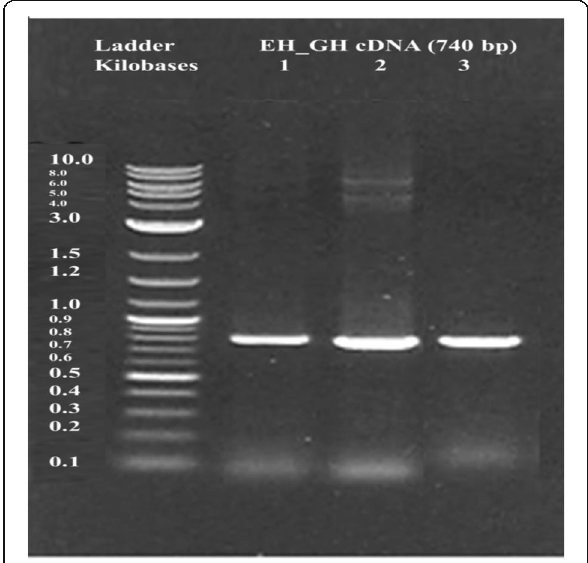
Fig. 2 Electrophoretic pattern of the EH_GH cDNA band. Ladder, DNA marker (100 to 10,000 bp); EH_GH cDNA, Egyptian × Holstein growth hormone cDNA; 1, 2, and 3 are the samples of EH_GH